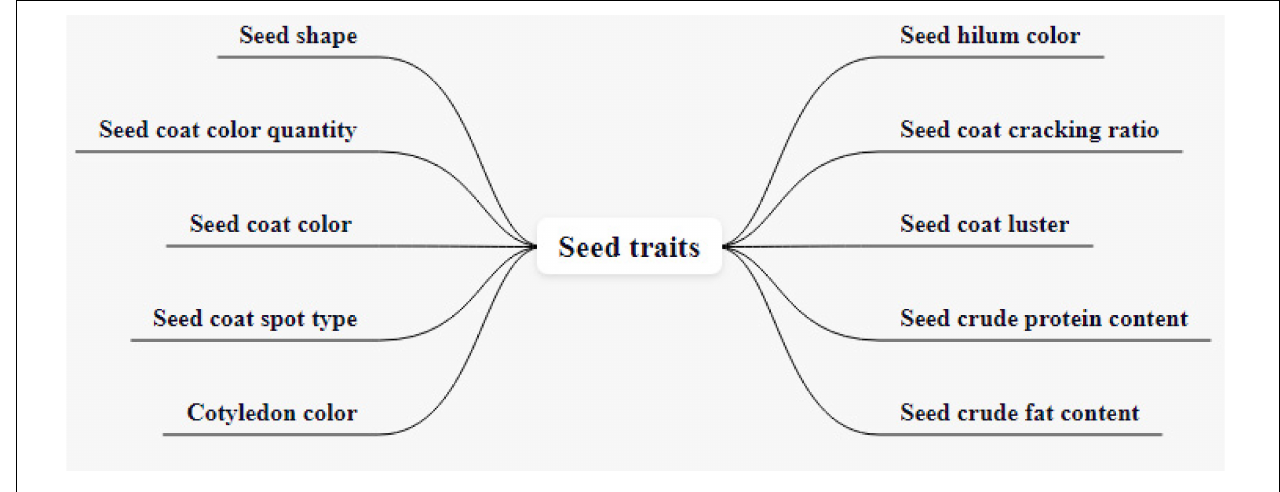
FIGURE 7 | Soybean test original traits.